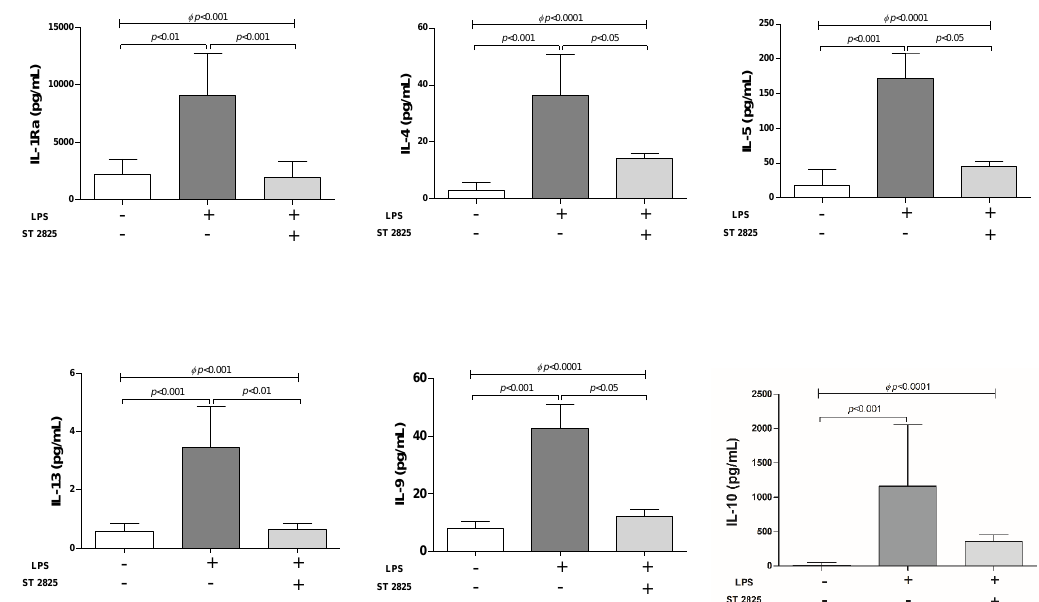
Figure 3. Effect of ST2825 on inhibition of anti-inflammatory cytokine secretion in the supernatant of LPS-stimulated PBMC. The soluble pro-inflammatory cytokines were determined in the PBMC supernatant of HBD (n = 10). PBMC (1 × 10 6 cells per well at a final volume of 1 mL) were cultured for 24 h under three different conditions: First, RMPI medium alone; second, LPS (30 ng/mL) and third, LPS (30 ng/mL) plus ST2825 (30 μM). Data provided in median and interquartile ranges ( Φ Kruskal- Wallis test and multiple comparisons by Dunn’s test).